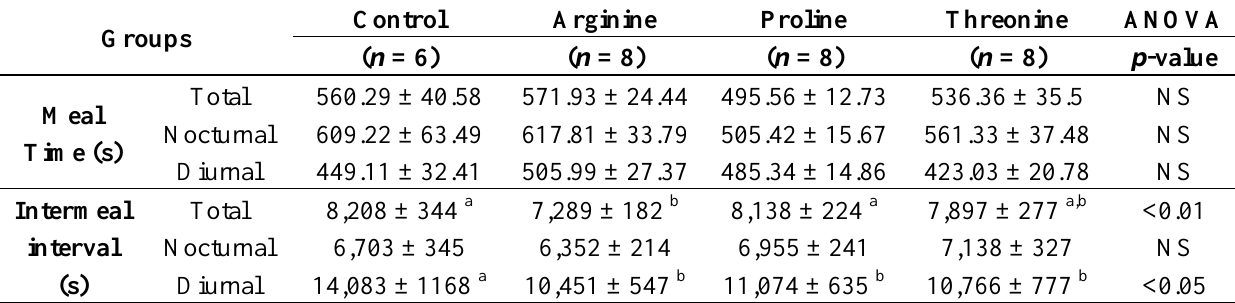
Table 7. Meal time and intermeal interval of rats fed on diets supplemented with 5% arginine, proline or